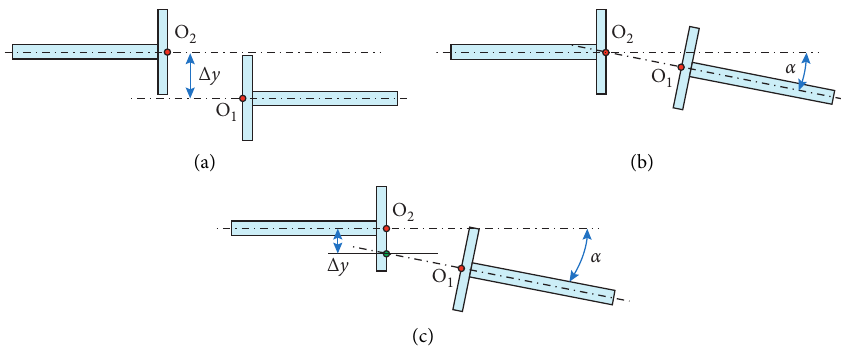
Figure 1: (a) Parallel misalignment, (b) angular misalignment, and (c) combined